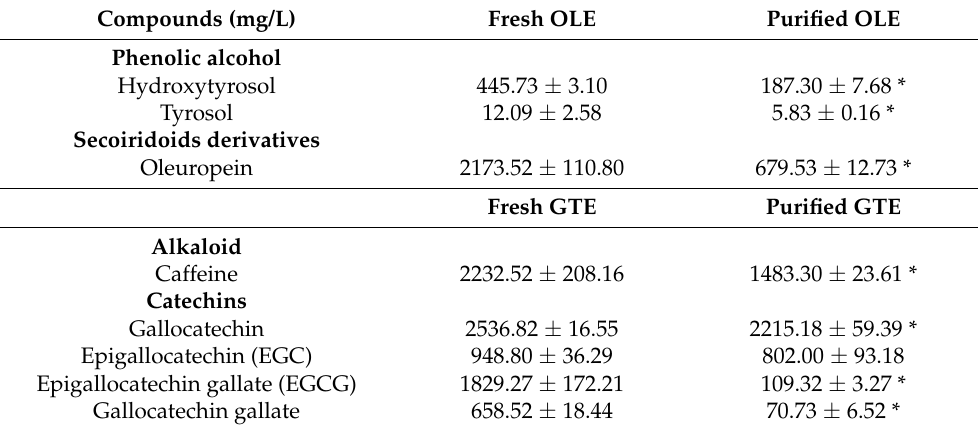
Table 1. Major phenolics content of fresh and dechlorophyllized olive leaves (OLE) and green tea (GTE)